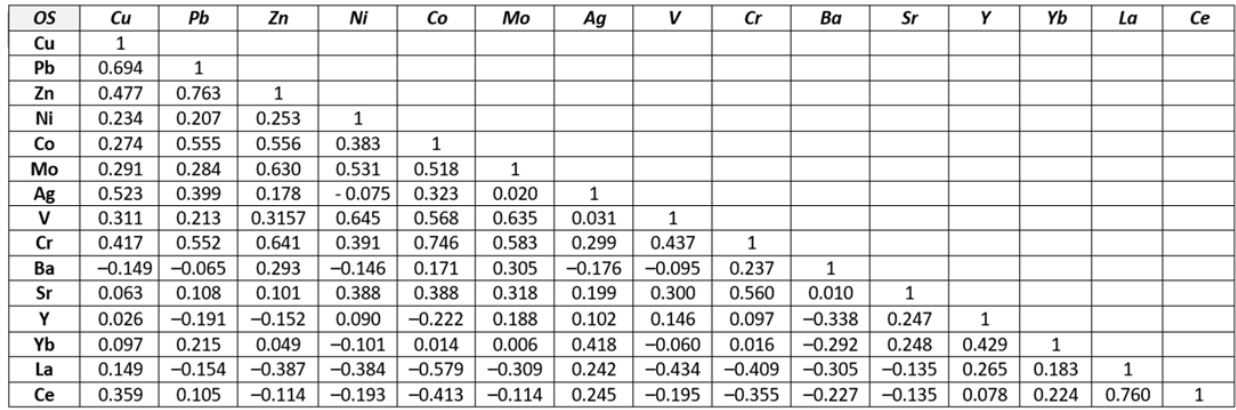
Figure 9. Correlation coefficient of chemical components in OS. The highest Pearson coefficient indicate the following pairs: Zn–Pb, Cu–Pb, Zn–Mo, Zn–Cr, Ni–V, Ag and V, La–Ce, Sr–Cr, Co, Ni, Mo. Table 1. Minimum values, maximum values, averages, and median parameters for ZM and OS (on the basis of data from Tables S1 and S2 in Supplementary Materials).